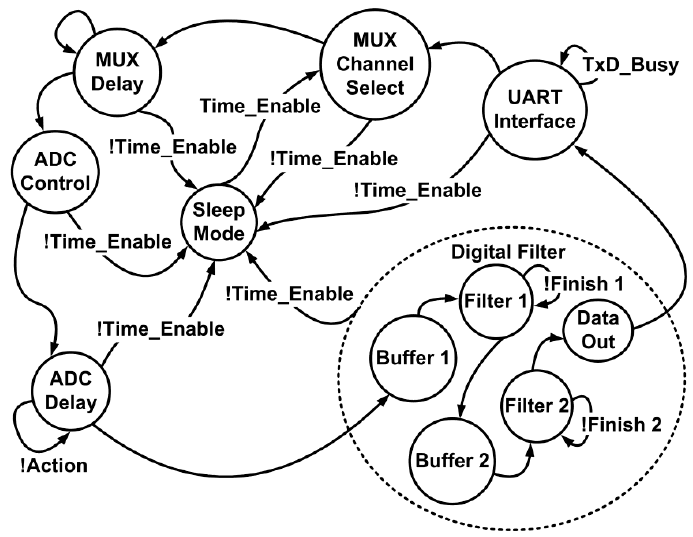
Figure 10. State diagram of the control